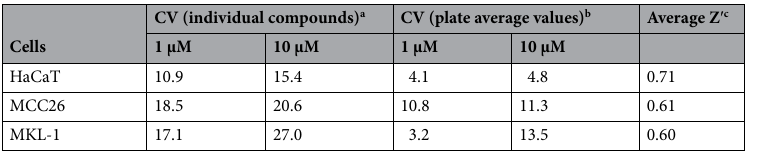
Table 1. Assay reproducibility—repeat assays with LOPAC compounds. CV = sd/average × 100%. a average CV for each of 1280 compounds (n = 3 repeats per cell line). b average CV for mean plate response (n = 3 repeats per cell line). c Average Z ′ , n = 24 plates per cell line (LOPAC only).